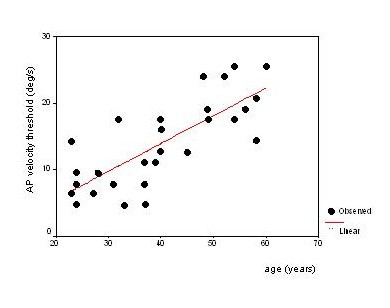
Velocity threshold of anterior-posterior linear movement as a function of age. Thresholds increase with age (median velocity threshold = -2.8 + 0.42 × age (p < 0.001, r = 0.775).